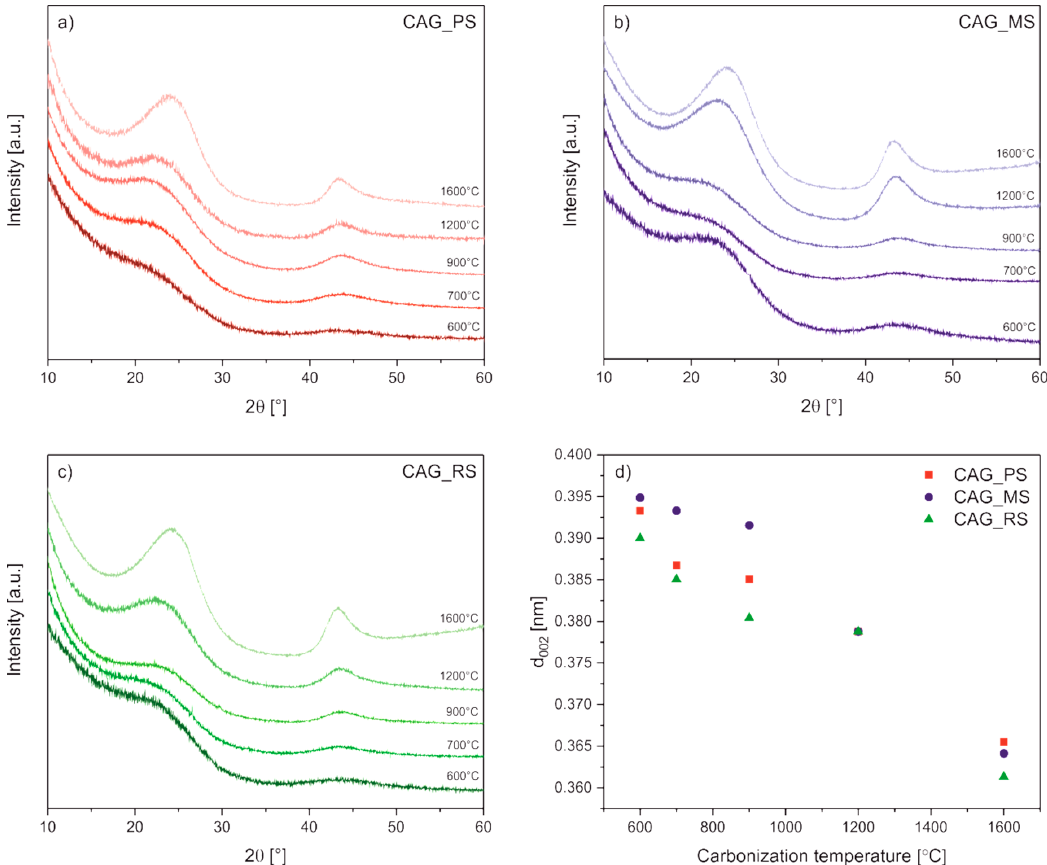
Figure 1. X ‐ ray diffraction patterns of carbon aerogels derived from ( a ) potato starch (PS), ( b ) maize starch (MS), and ( c ) rice starch (RS) carbonized at temperatures ranging from 600–1600 °C as well as ( d ) the correlation between interplanar spacing d 002 and the carbonization temperature of all carbon aerogel (CAG) samples.